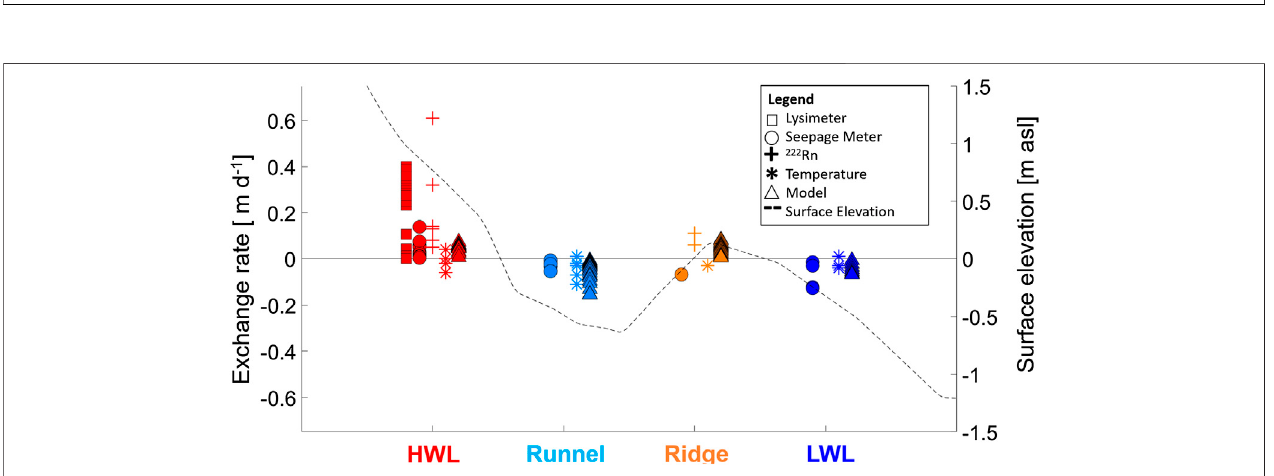
Frontiers in Earth Science |